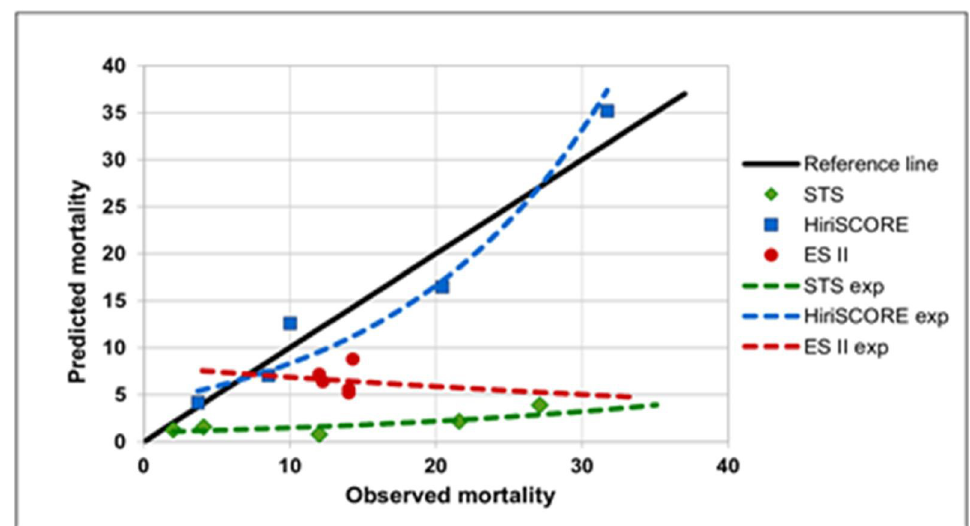
Fig 2. Calibration-in-the-large for ESII, STS and HiriSCORE for high-risk CABG.